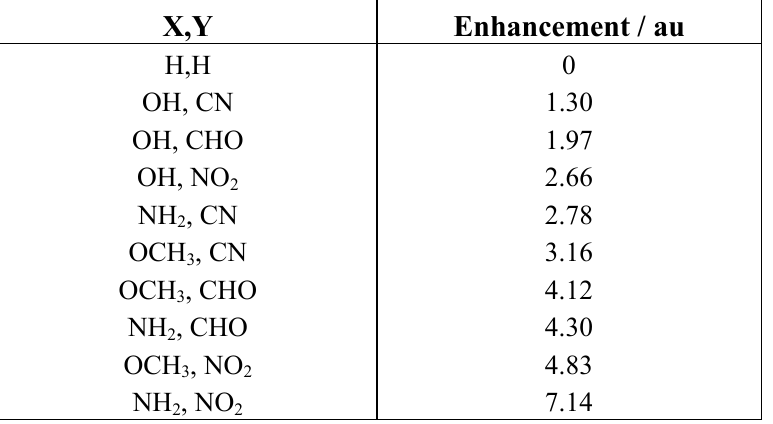
Table 5. Push-pull enhancements to < α >